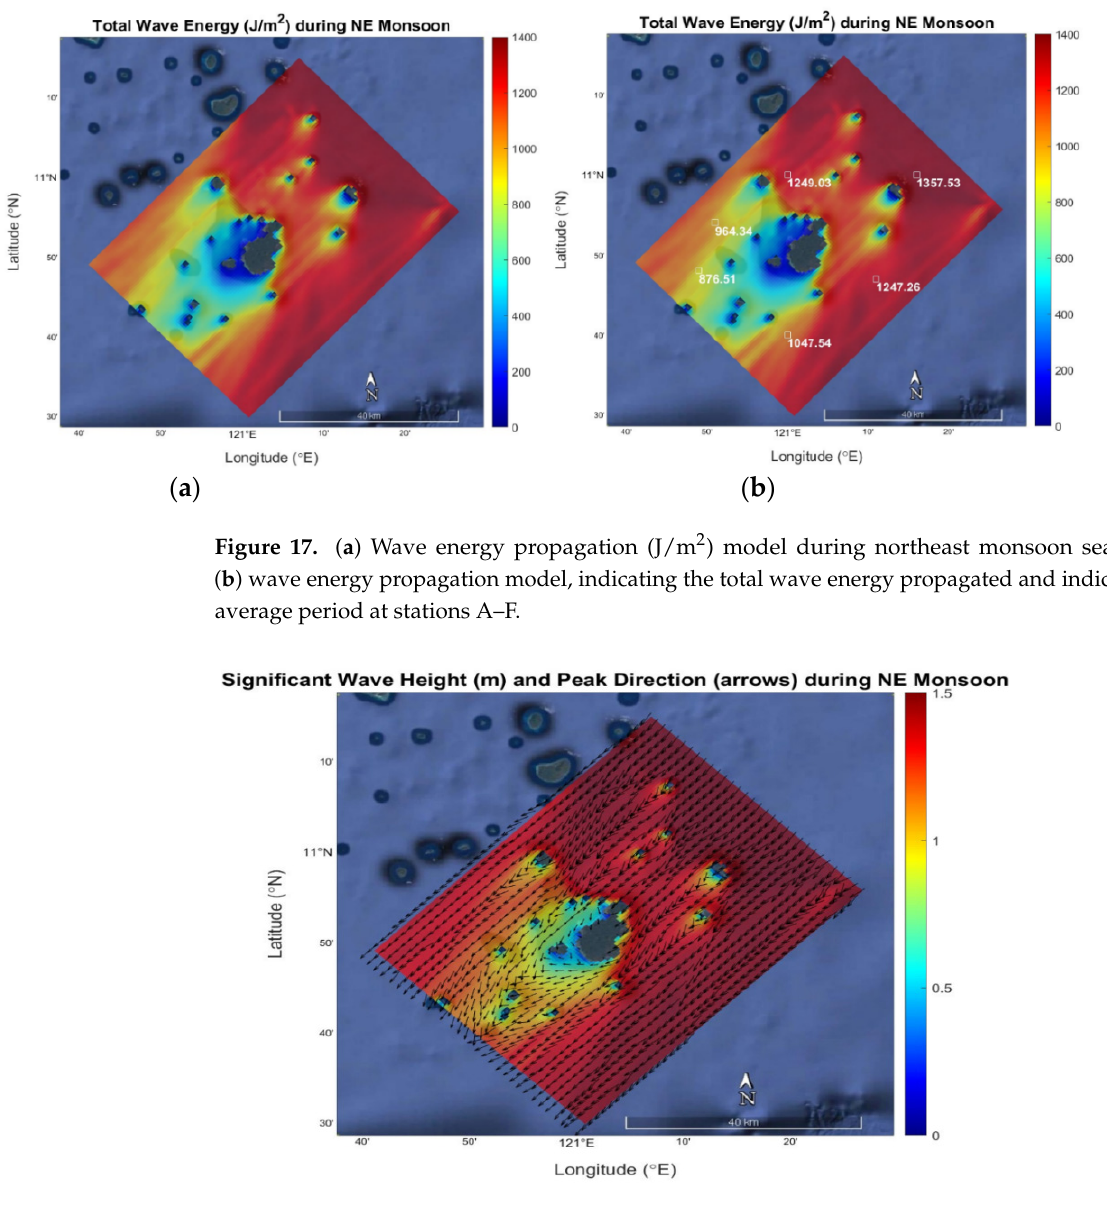
Figure 16. ( a ) T p (s) model during northeast monsoon season and ( b ) T p model indicating the average T p at stations A–F.